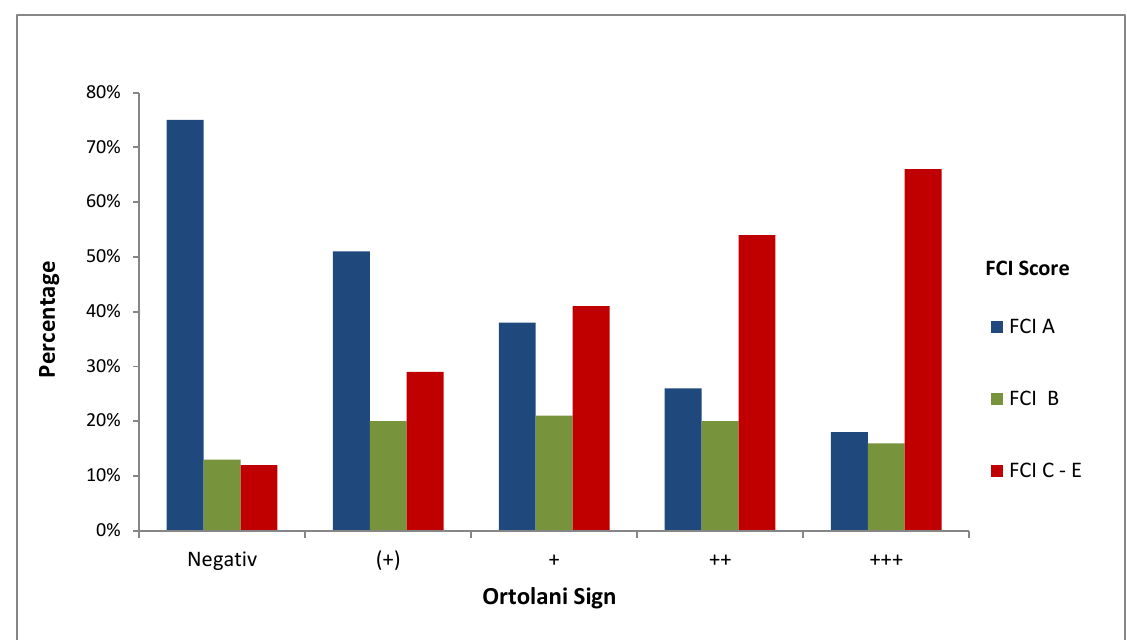
Figure 4. Ordinal regression of the Ortolani test and FCI scoring method in 30 Rottweiler puppies.